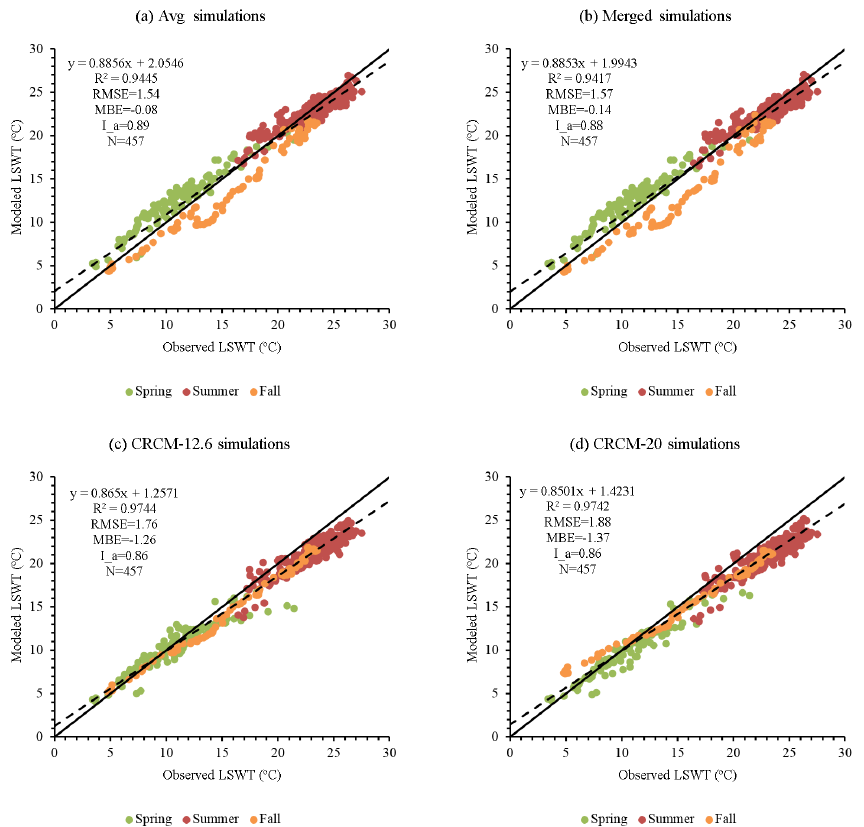
Figure 5. Modeled ( y axis) versus observed ( x axis) LSWT for yearly average, merged, CRCM-12.6, and CRCM-20 simulations during the ice-free seasons in 2005–2007. A linear fit (dashed line) and its coefficients are shown on the plot. The statistics related to the regression of parameters, and a 1 : 1 relationship (solid line) are also shown. The average LSWT values of Obs, Avg, Merged CRCM-12.6, and CRCM-20 simulations are 18.64, 18.56, 18.50, 17.38, and 17.27 ◦ C,